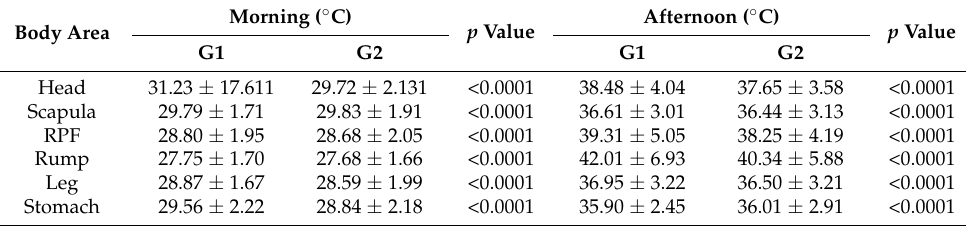
Table 5. Skin temperatures of heat-stressed G1 and G2 ewes during summer in a tropical region. Body